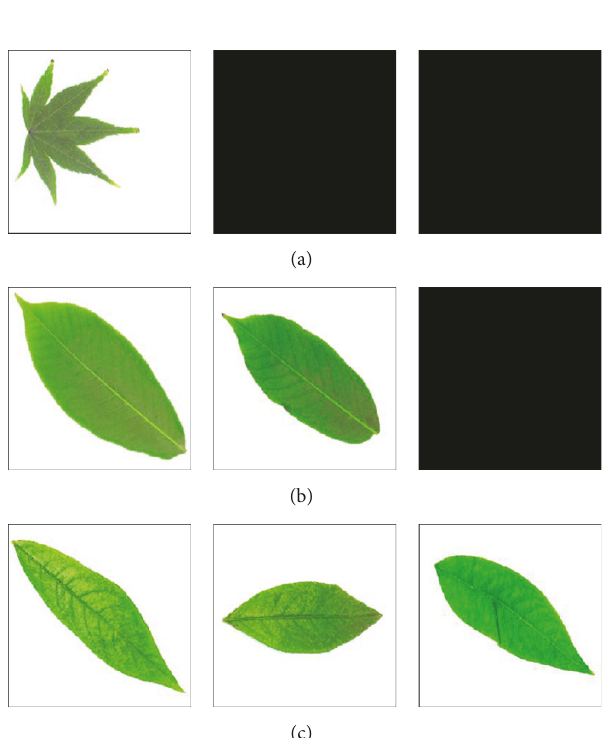
Figure 2: Observation-centered sample with (a) one, (b) two, and (c)threeleaves.Samplescontaininglessthanthreeleavesarepadded with